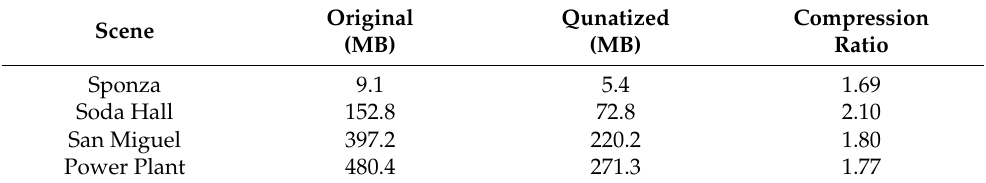
Table 3. Size reduction for a triangular mesh in the the indexed-face-set format. The ratio achieved by the presented quantization method is dependent on both the size of mesh and the ratio between the numbers of faces and vertices. See the text for